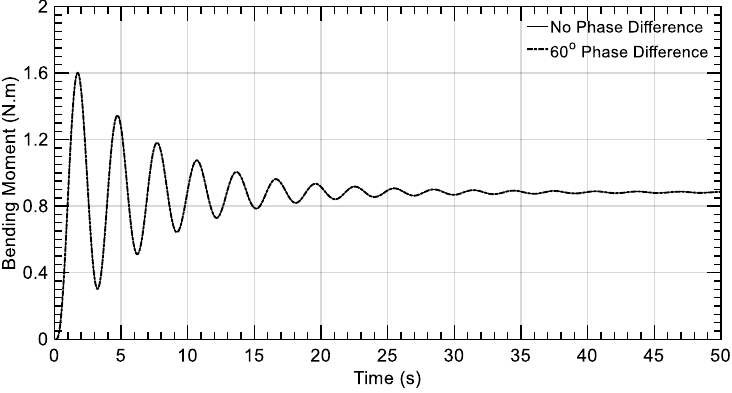
Figure 21. Dynamic responses of the tower: single-rotor vs. twin-rotor load case 1: ( a ) tower-base, fore-aft bending moment, and ( b ) tower-top, fore-aft deflection.